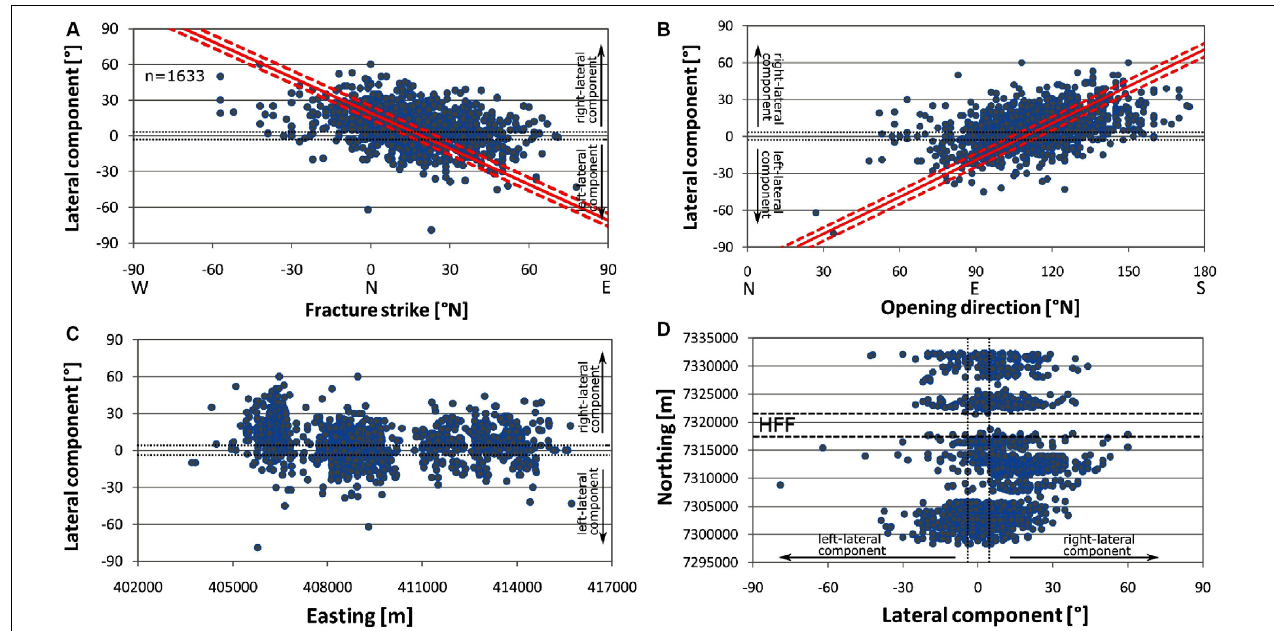
FIGURE 7 | (A) Graph of the lateral component of opening directions ( Y axis) with respect to fracture strike ( X axis), (B) opening direction ( X axis) vs. lateral component ( Y axis). In (A,B) , red stripes indicate how the lateral component is expected to change in case of variations of the values along the X axis, according to plate separation vector range (N104-115 ◦ ). (C) Graph of lateral component ( Y axis) vs. Easting ( X axis), (D) graph of lateral component ( X axis) vs. Northing ( Y axis); the intersection with the HFF is shown. Black dashed lines enclose pure extension fractures, with lateral component values < 5 ◦ . Spatial reference: WGS 84/UTM zone